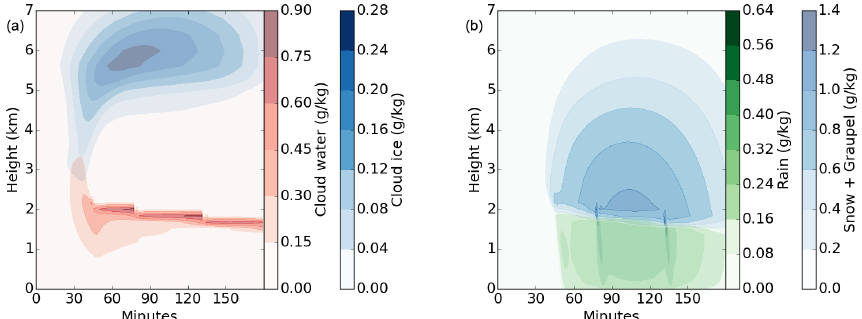
Figure 3. Time-height cross-section of (a) cloud water and cloud ice and (b) rain, snow+graupel in the single-column orographic lift